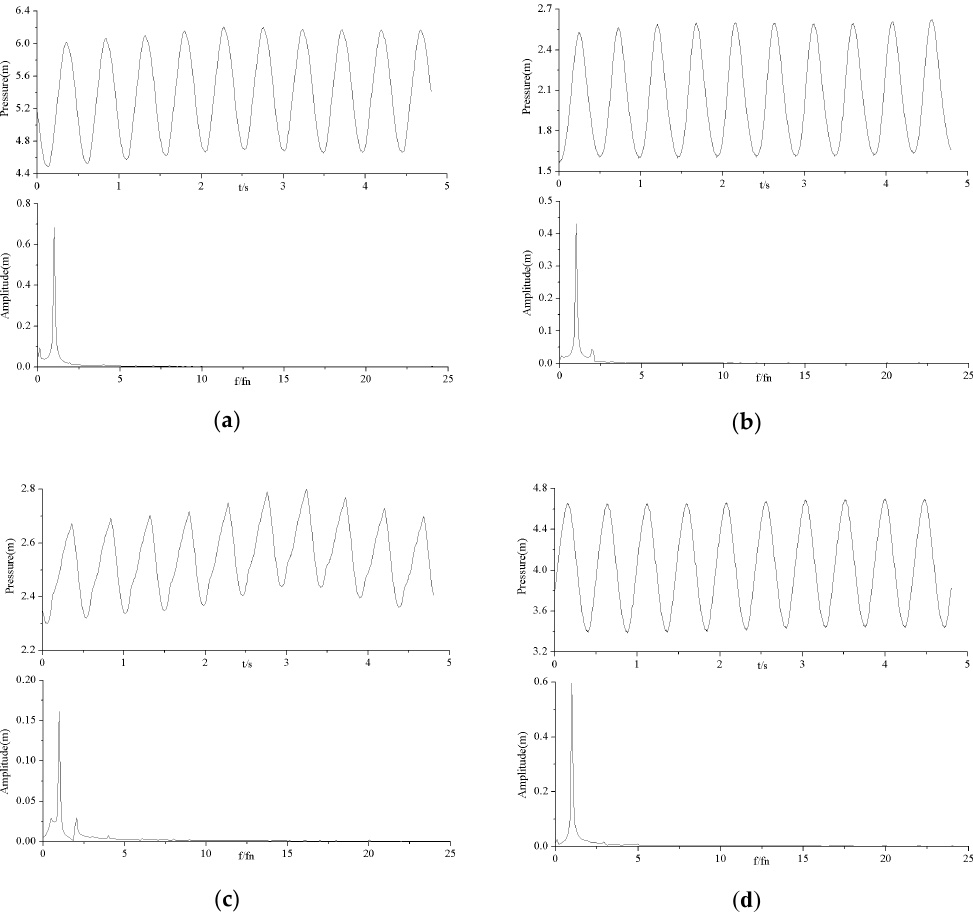
Figure 12. Time and frequency histories of pressure pulsations on the blade points for an optimal four-bladed runner: H = 3 m. ( a ) RP-ebb mode; ( b ) RP-flood mode; ( c ) RS-ebb mode; ( d ) RS-flood